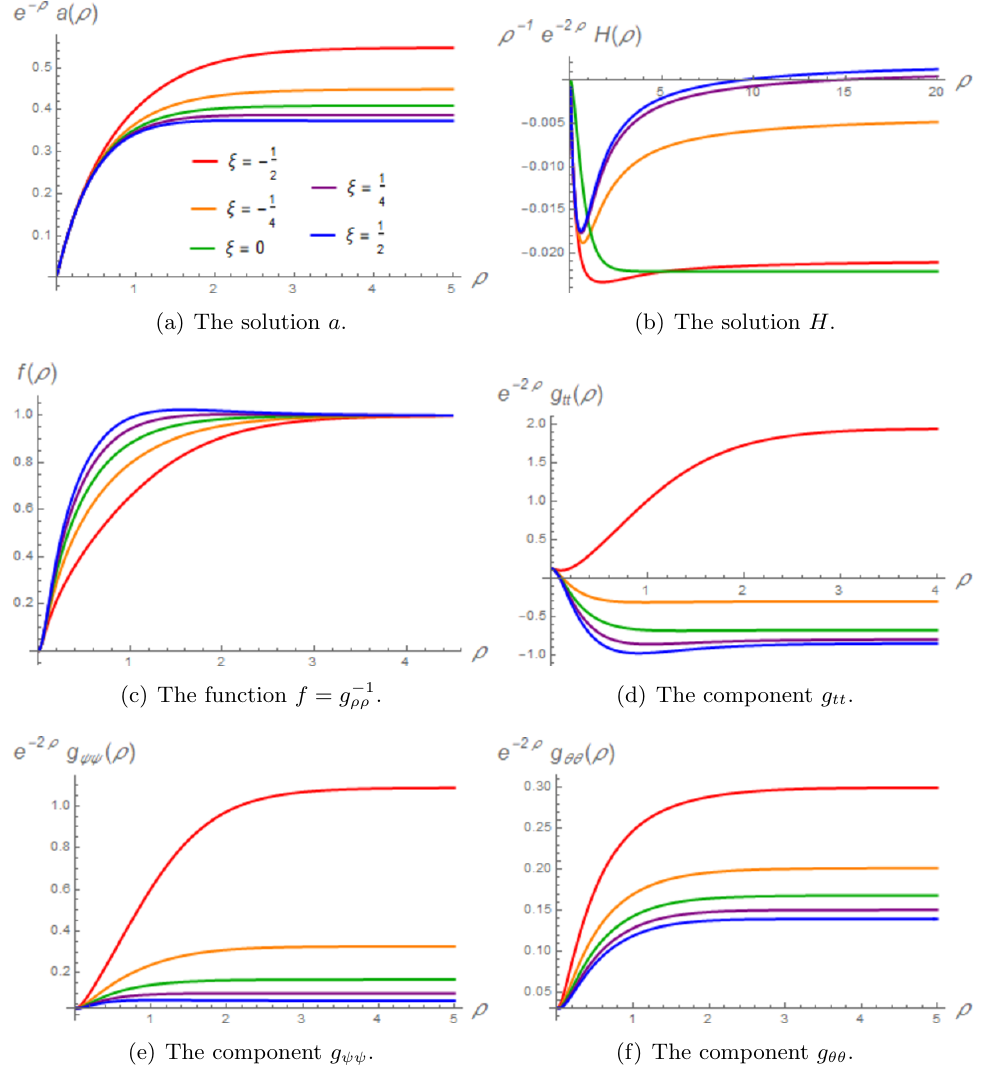
Figure 2 . Relevant functions and metric components of our solution, rescaled by their